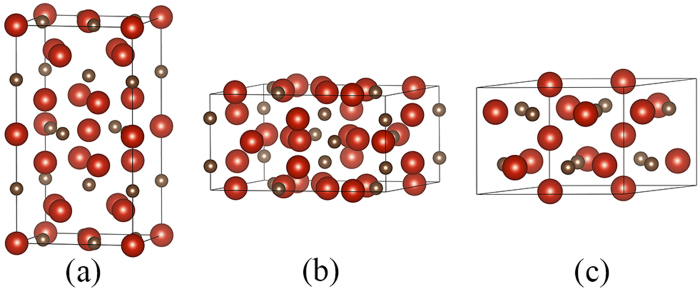
Structure models of V5C3: (a) Cr5B3-type, (b) W5Si3-type, (c) Mn5Si3-type. The large and small spheres represent V and C, respectively.